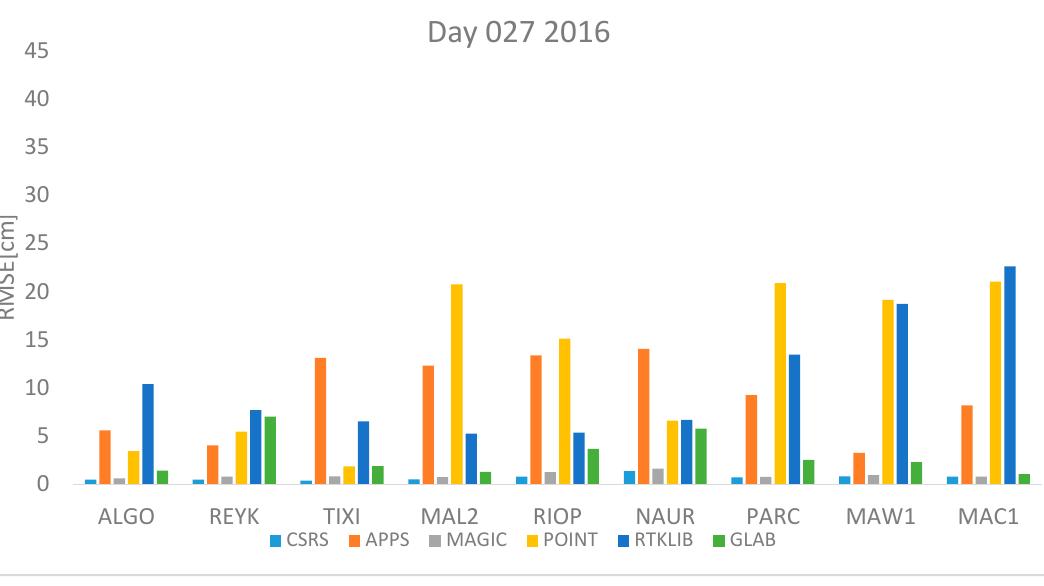
Figure 1. RMSE in centimeters for day 27 2016.